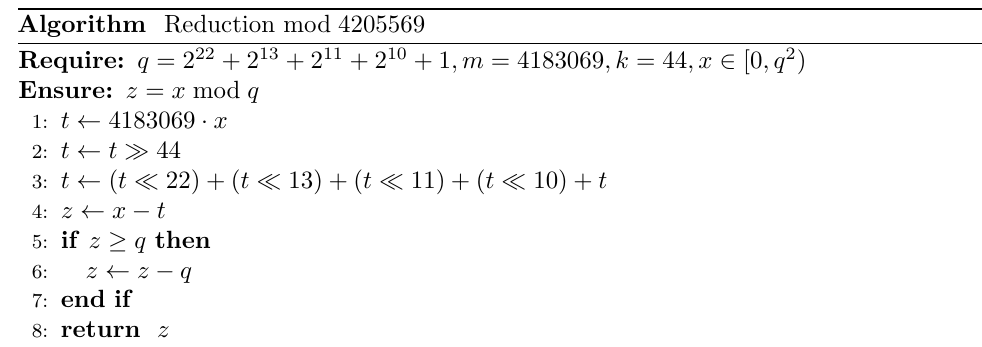
Algorithm Reduction mod 4205569